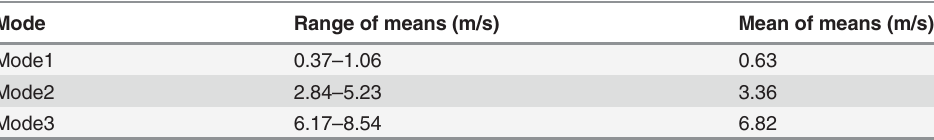
Table 2. Results of k-means analysis of travel